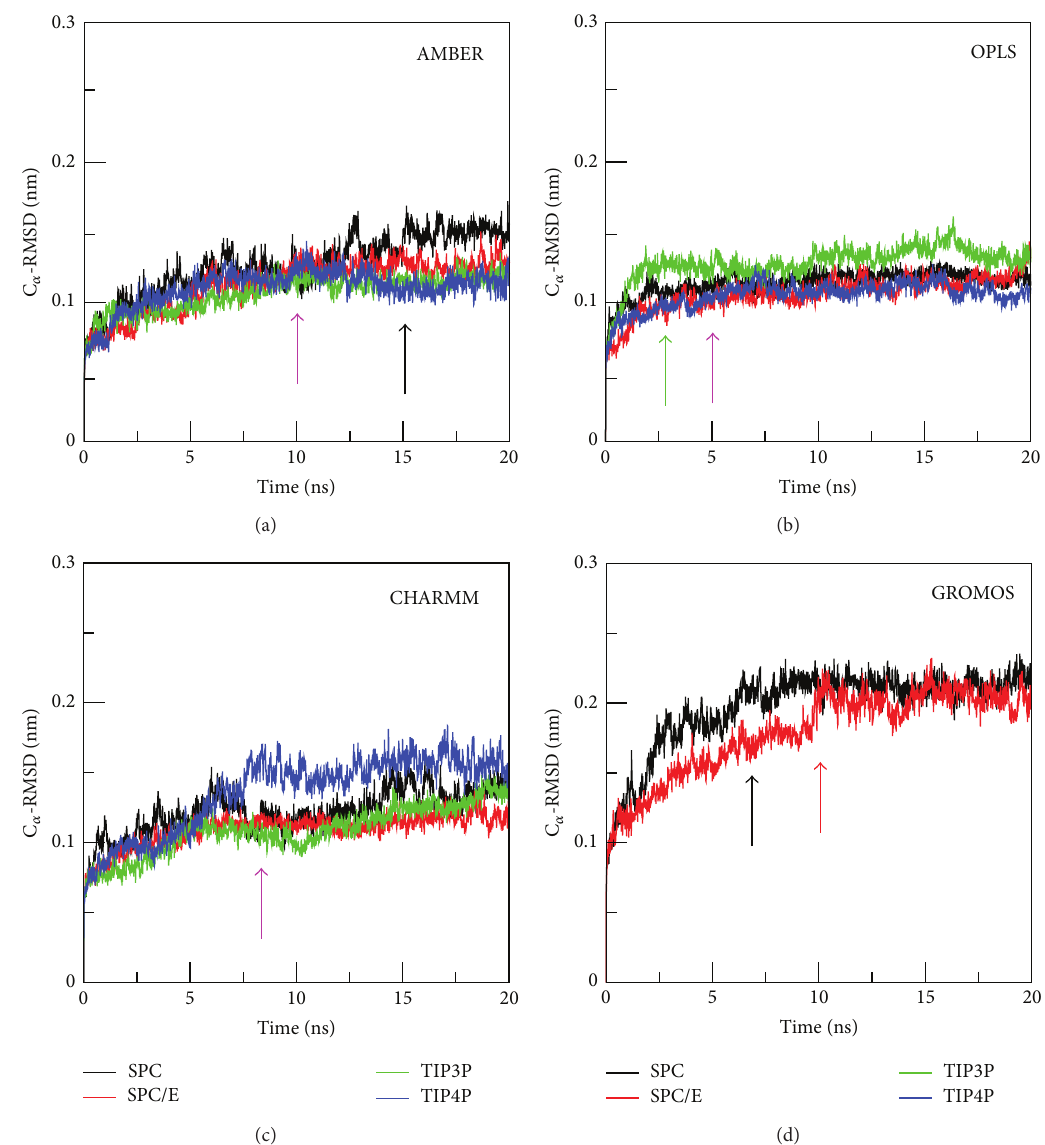
Figure 3: C 𝛼 -RMSD of wild-type NA when interacting with Tamiflu during 20 ns simulations with different combination of force fields and ≈ 15 ns for SPC (black arrow) while 𝑡 ≈ 10 ns for remaining water models (magenta water models. For AMBER equilibration time 𝑡 eq eq ≈ 3 ns for TIP3P (green arrow) and 5 ns for other models (magenta arrow). In the CHARMM case all systems reach arrow). In OPLS 𝑡 eq ≈ 7 ns (black arrow) and 10ns (red arrow) for SPC and SPC/E, equilibrium after about 8ns. For GROMOS 𝑡 eq